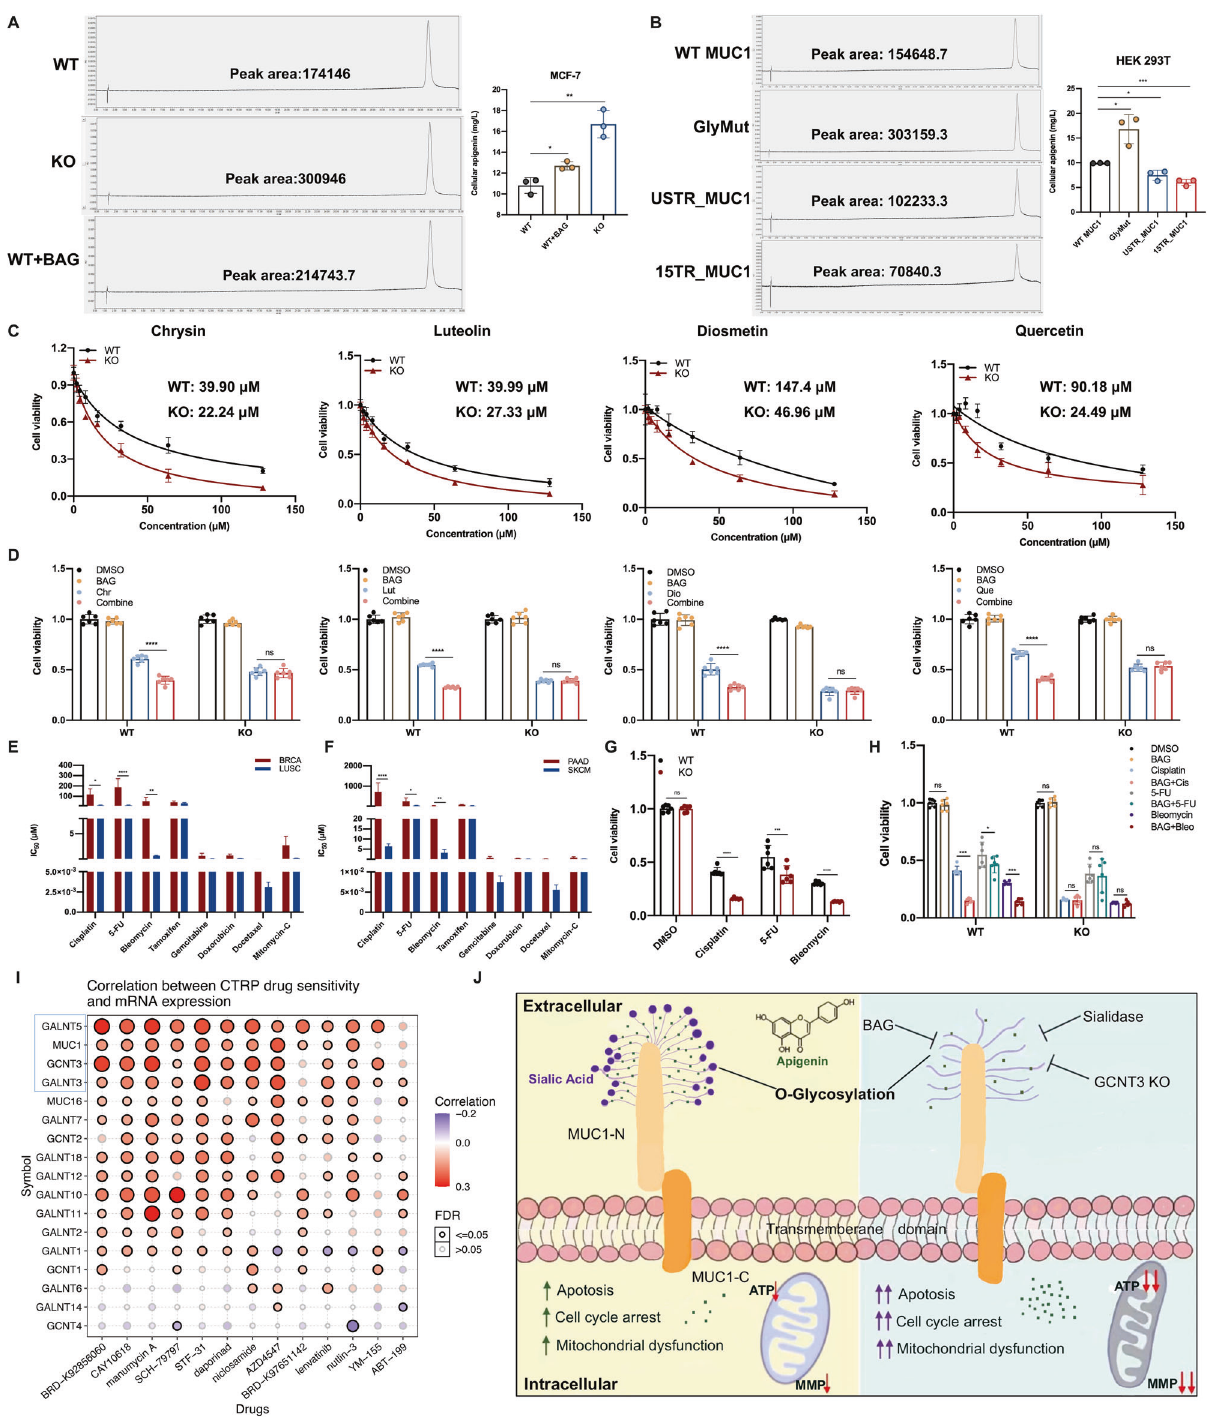
Fig. 5 The detection of intracellular apigenin uptake and validation for multiple chemotherapeutics. A The determination of intracellular apigenin concentration in WT, KO and 2 mM BAG-pretreated MCF-7 cells. B The detection of intracellular apigenin concentration in plasmids transfected HEK 293 T cells. C IC 50 of WT/KO cells treated with different natural compounds for 48 h. D Cell viability of WT/KO cells pretreated with 2 mM BAG for 24 h then 50 μ M natural compounds for 48 h. E Calculated IC 50 for selected drugs in BRCA and LUSC cell lines, respectively. MUC1 is overexpressed in BRCA, but little expressed in LUSC. F Calculated IC 50 of selected drugs in PAAD and SKCM cell lines, respectively. G Cell viability of WT/KO cells treated with selected drugs for 48 h. H Cell viability of WT/KO cells pretreated with 2 mM BAG for 24 h thereafter selected drugs for 48 h. I Correlation between drug sensitivity and mRNA expression of MUC1 and related O-glycosyltransferase genes from CTRP database. Most of these genes were positively (red) correlated with drug tolerance, implying that MUC1 along with over-glycosylation possibly leads to drug resistance. J A proposed model of MUC1 O-glycosylation induced resistance to apigenin treatment. Extensive O-glycosylation on MUC1 N-terminal induces drug resistance and mitigate cellular apoptosis, cell cycle arrest and mitochondrial dysfunction. Each group was analyzed in triplicate. * P < 0.05; ** P < 0.01; *** P < 0.001 for